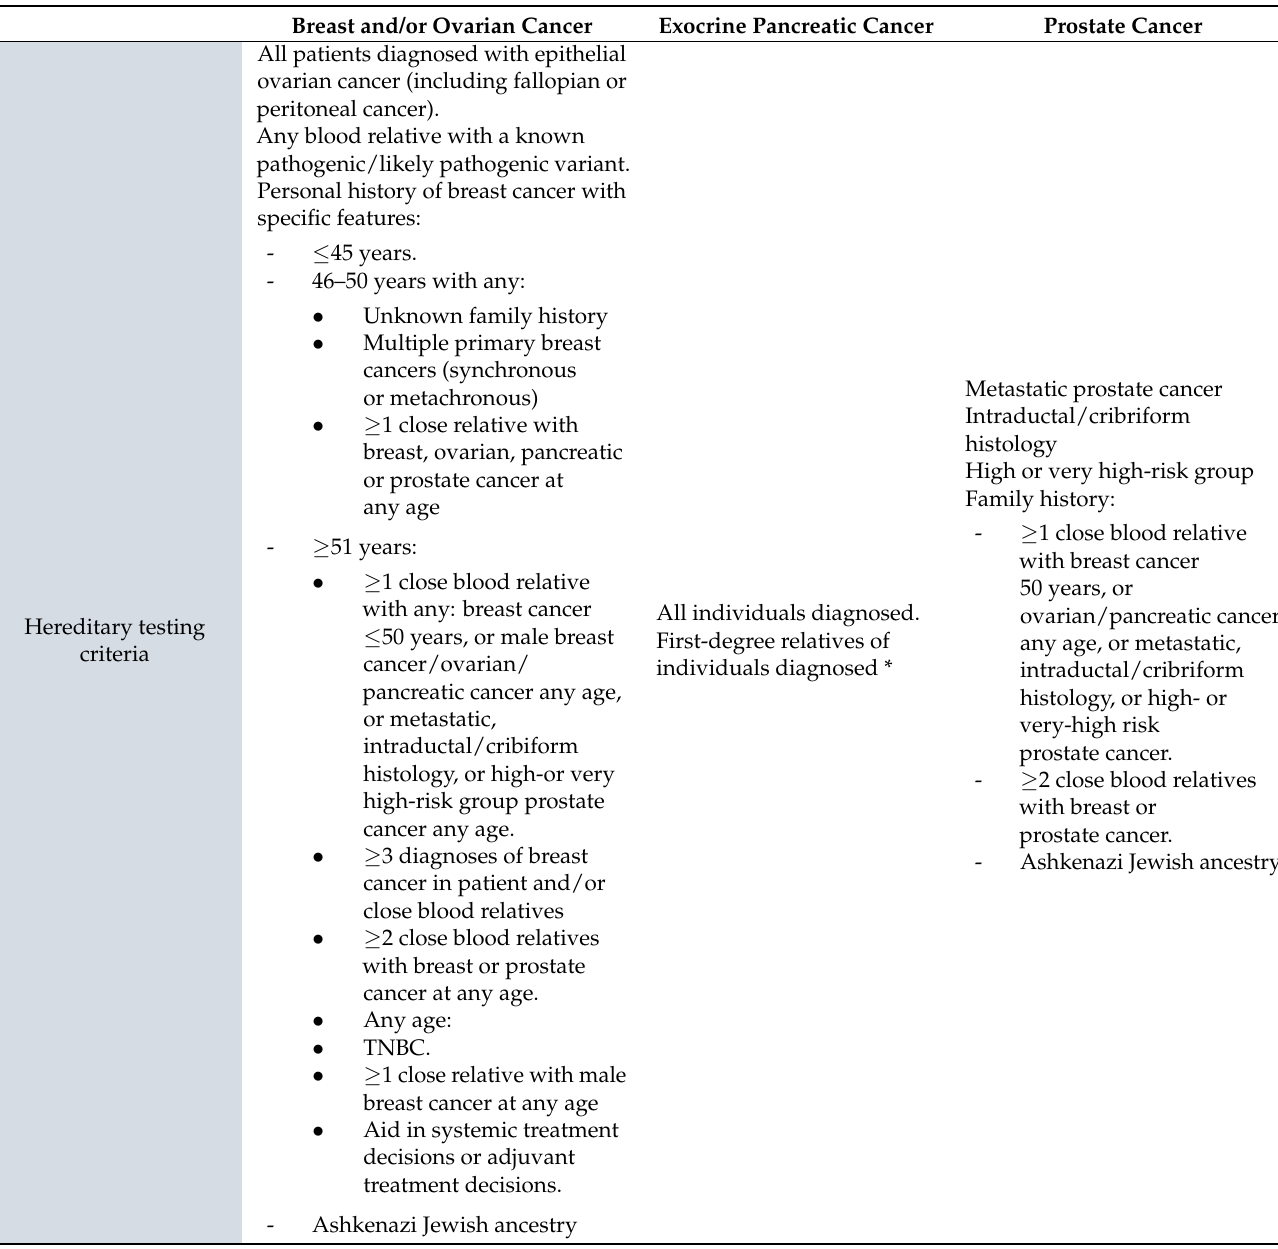
Table 3. Genetic testing recommendations for breast and/or ovarian cancer, exocrine pancreatic cancer and prostate cancer. National Comprehensive Cancer Network (NCCN) guidelines V2.2022, American Society of Clinical Oncology (ASCO) somatic genomic testing and European Society of Medical Oncology (ESMO) recommendations for the use of next-generation sequencing (NGS) in metastatic cancer. Breast and/or Ovarian Cancer Exocrine Pancreatic Cancer Prostate